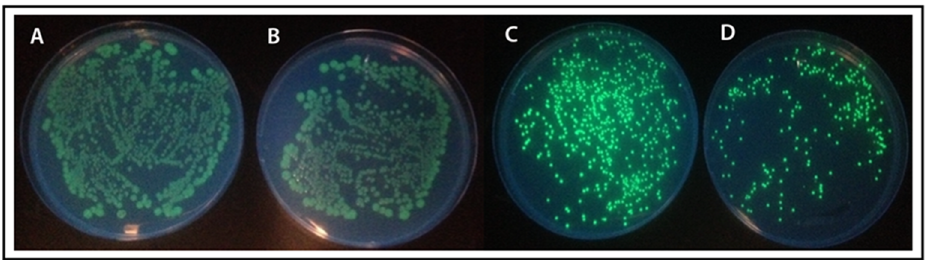
Figure 5. On plate protein expresssion screening. Plate ( A , B ): N -terminally fused MLB and SNA to GFP; Plate ( C , D ): C -terminally fused MLB and SNA to GFP.